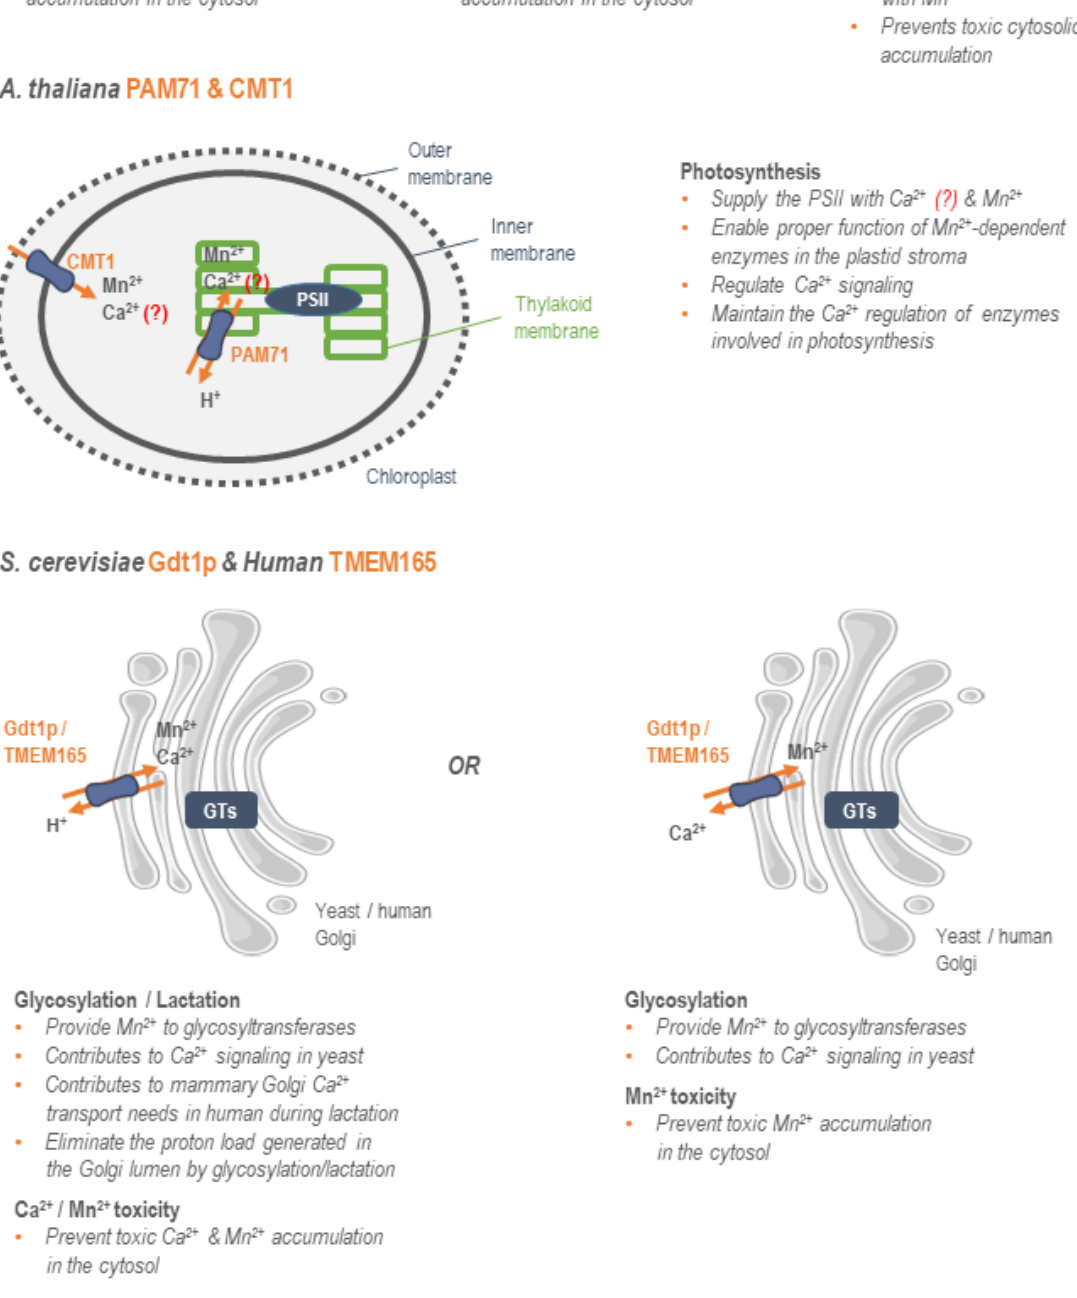
FIGURE 2: Mode of action of the currently studied UPF0016 members. The direction of transport of the UPF0016 members’ substrates from their respective subcellular localization is indicated by orange arrows. Their putative implication in key physiological processes is indicated. Functions that are still unclear in the literature are indicated by (?) (PSII: photosystem II, GTs: OPEN ACCESS | www.microbialcell.com